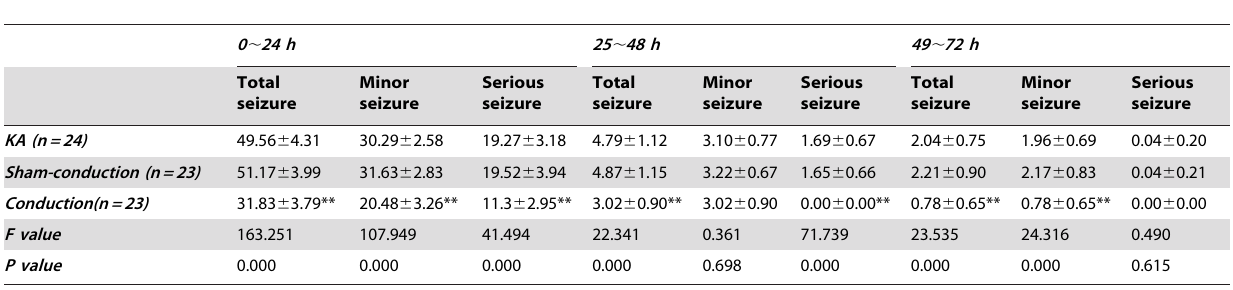
Table 1. Frequency of behavioral seizures in TLE model (mean 6